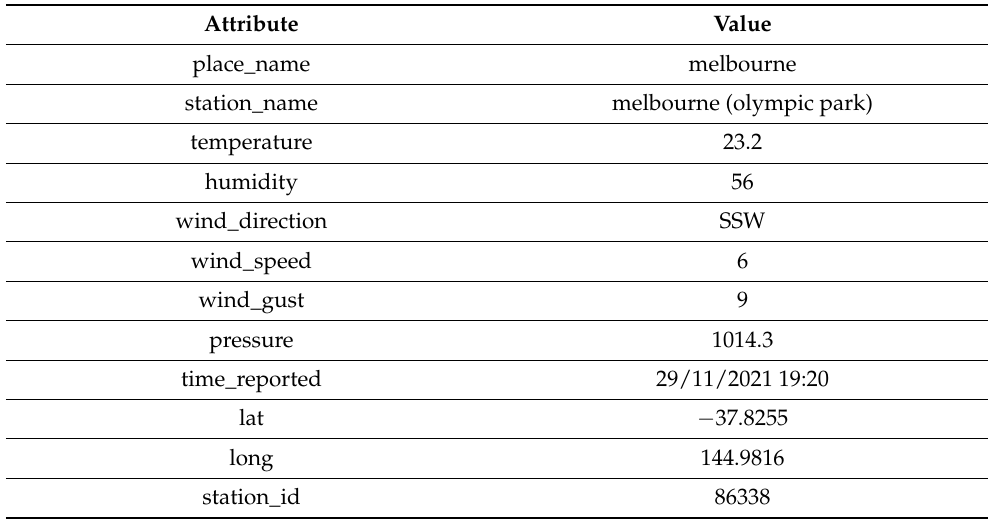
Table 9. Sample observation from the Melbourne Olympic Park weather